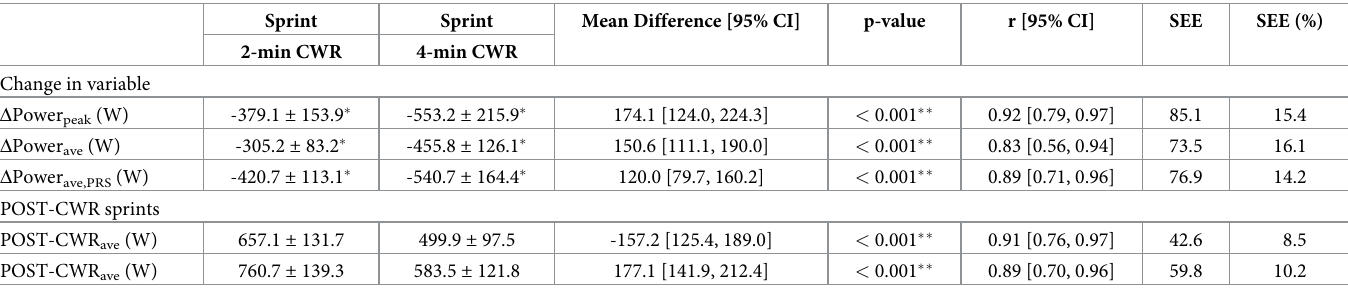
Table 2. Differences in mechanical variables recorded during sprints performed before (PRE-CWR) and after (POST-CWR) the 2-and 4-min CWR tests ( n =